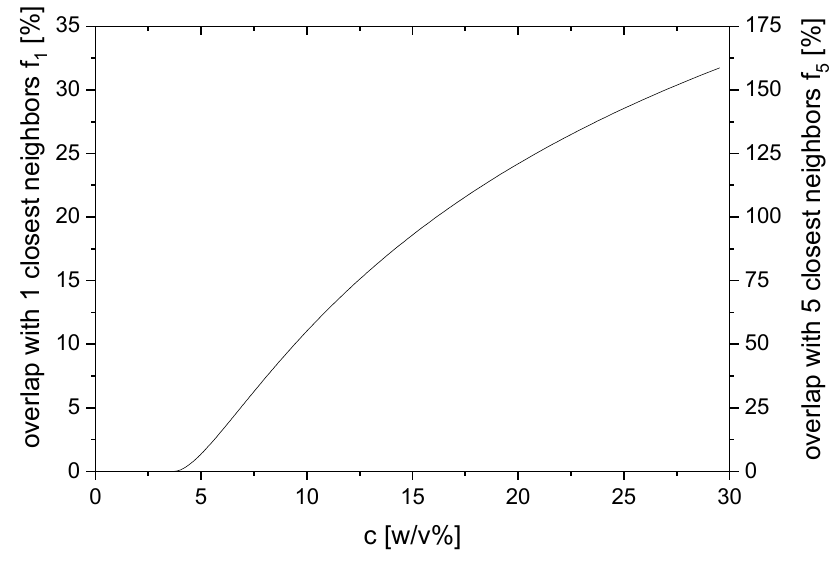
Figure 2. Overlapping fractions f 1 and f 5 as a function of concentration.